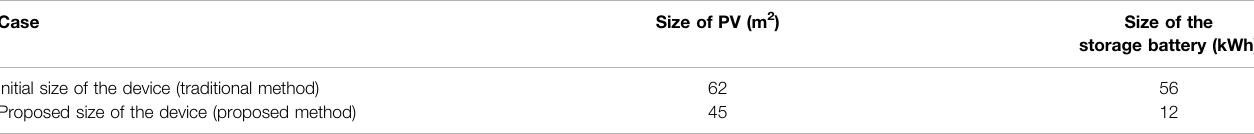
TABLE 5 | Device size under the two different sizing